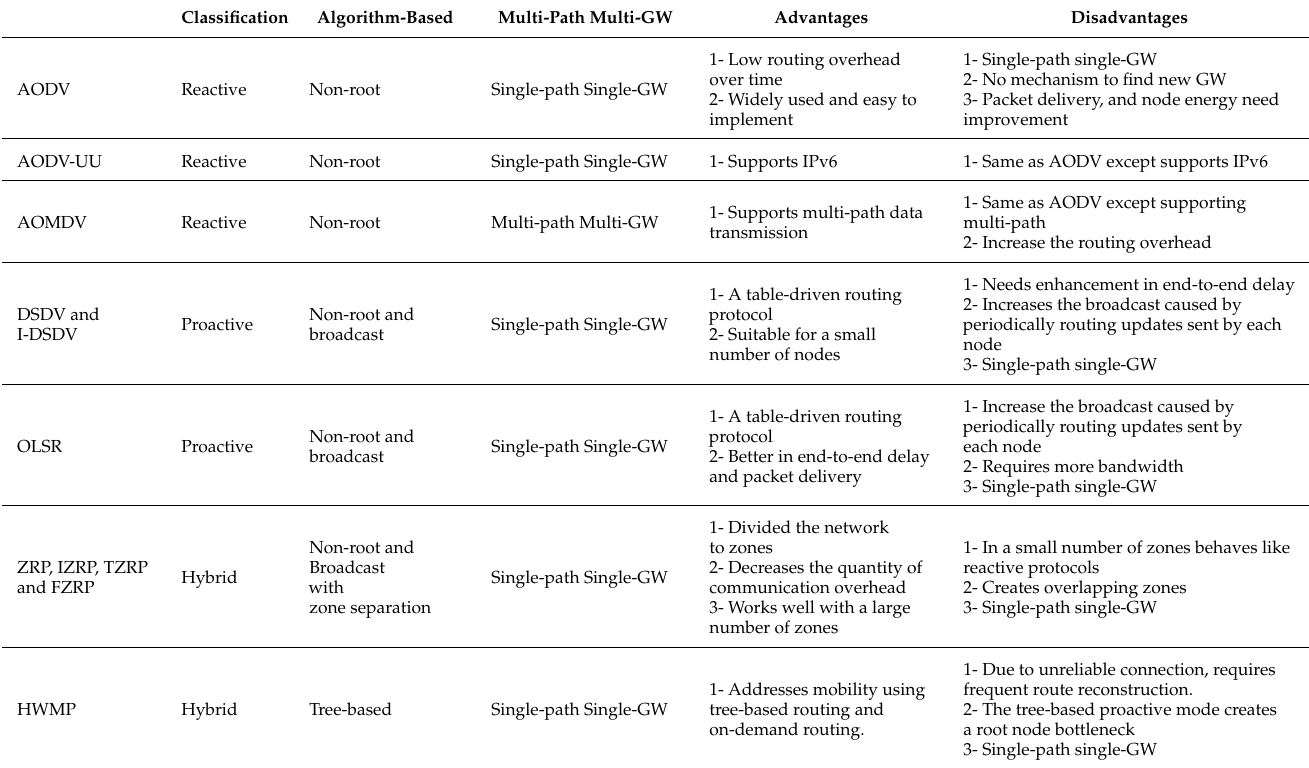
Table 1. Existing MANETs routing protocols